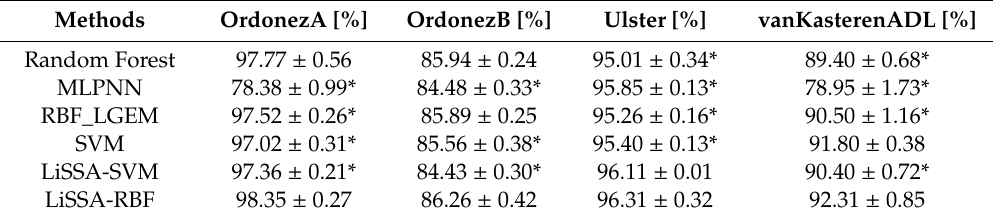
Table 4. Accuracy of di ff erent methods on four datasets. Results are obtained from 10-fold cross validations conducted five times.